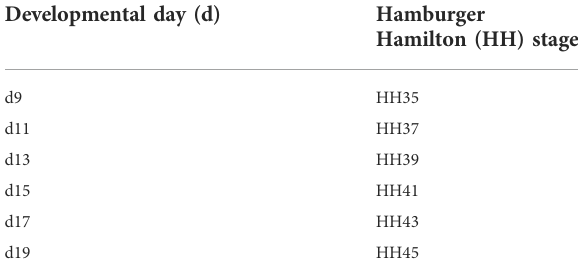
TABLE 1 Developmental days (d) and corresponding Hamburger Hamilton stages (HH) of chick embryos used in this study. Developmental day